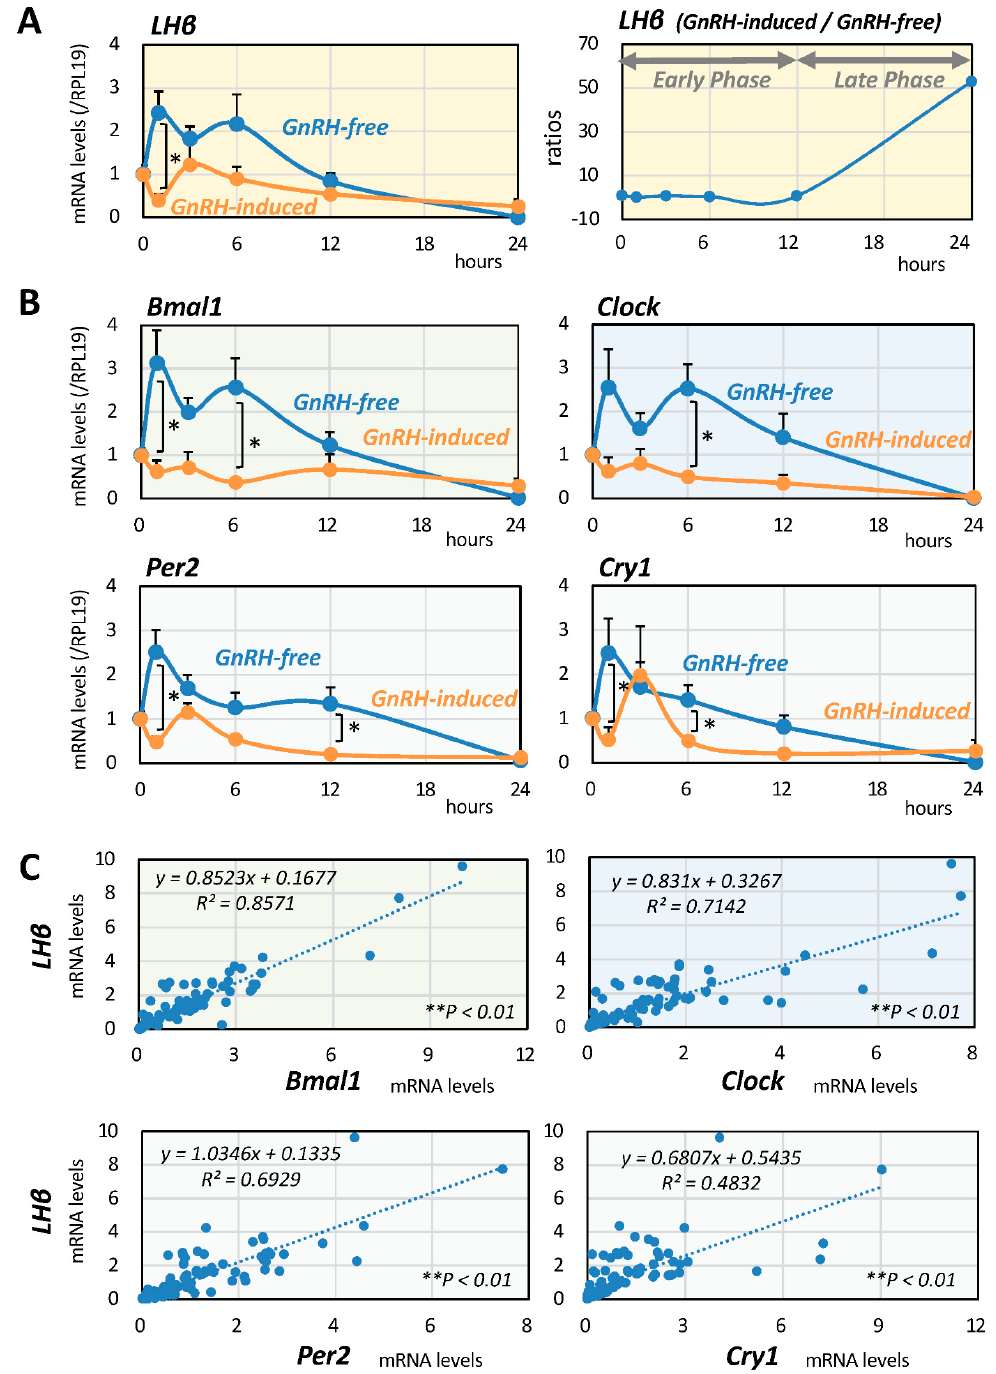
Figure 1. Serial changes in and interrelationships between LH and Clock gene expression induced by GnRH in mouse gonadotrope cells. L β T2 cells (1 × 10 5 cells/mL) were cultured with GnRH (10 nM) in serum-free DMEM for 24 h. At serial time points from 1 to 24 h, total RNAs were extracted, and the mRNA levels of ( A ) LH β and ( B ) Bmal1, Clock, Per2, and Cry1 genes were standardized by RPL19 levels and expressed as fold changes. Results are shown as means ± SEM and were analyzed by the unpaired t -test: * p < 0.05 between the indicated groups. Ratios of LH β mRNA levels in the presence of GnRH (10 nM) to those in the absence of GnRH at each time point are shown in the right panel of ( A ). ( C ) Cells (1 × 10 5 cells/mL) were treated with GnRH (10 nM) in serum-free conditions for 24 h. At serial time points from 1 to 24 h, total RNAs were extracted, and linear regression analysis was performed to determine the interrelationships between mRNA levels of LH β and Clock genes. * p < 0.05 and ** p < 0.01 of the significant